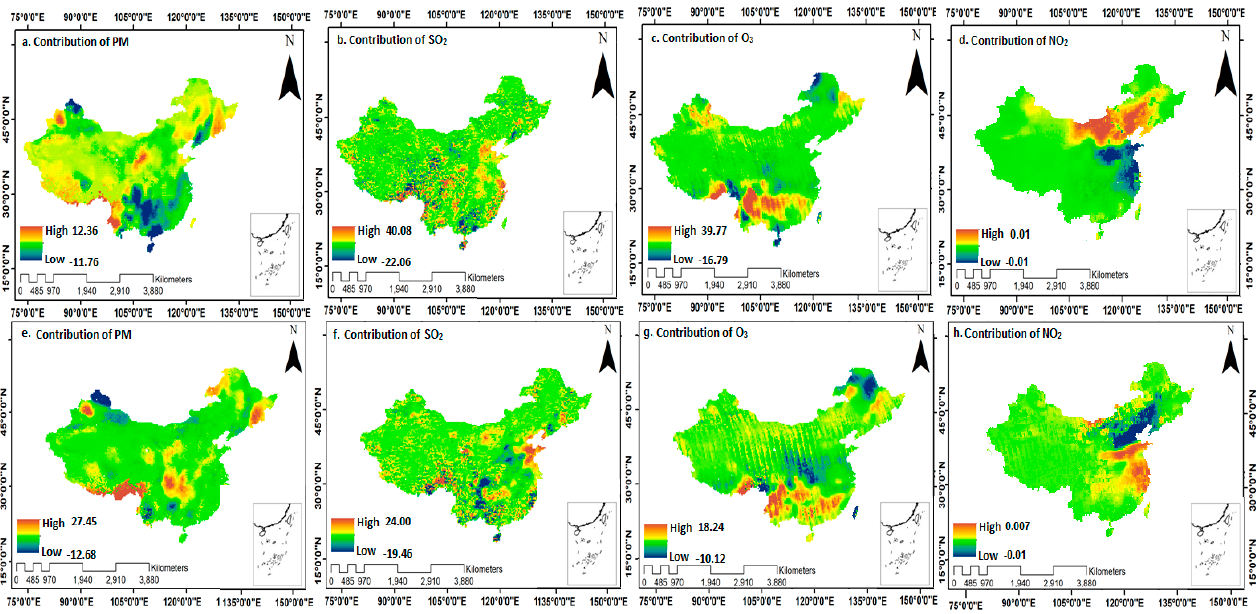
Figure 13. The contribution of air pollutants to precipitation (mm) pattern changes. Note: Pre-scenario ( a , b , c , d ) and Post-scenario ( e , f , g , h ).